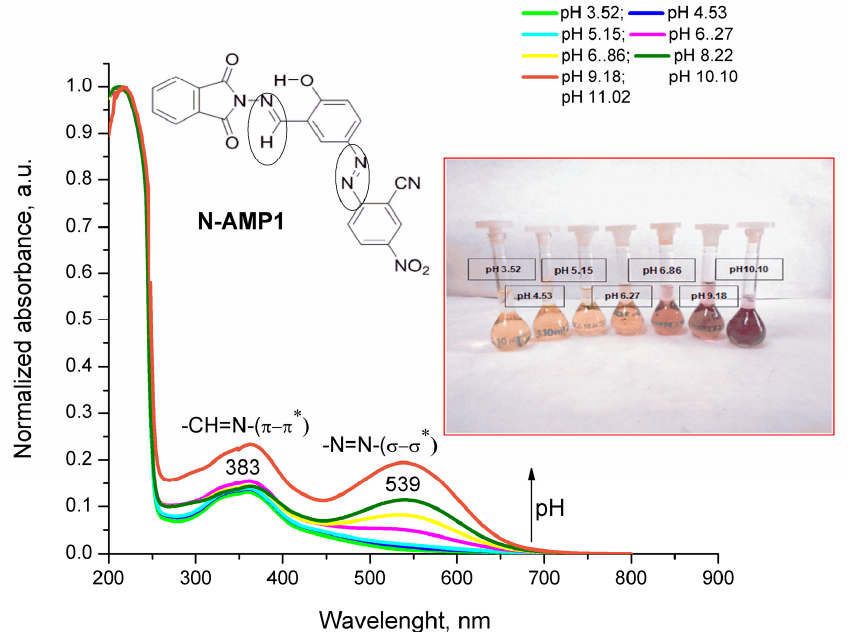
Figure 3. UV–Vis normalized spectra of N-AMP1 (L1) at equal concentration of analyte in each photometric solution (C = 6.81 × 10 − 5 mol L − 1 ) and different pH (buffer Robinson, pH 2–11).